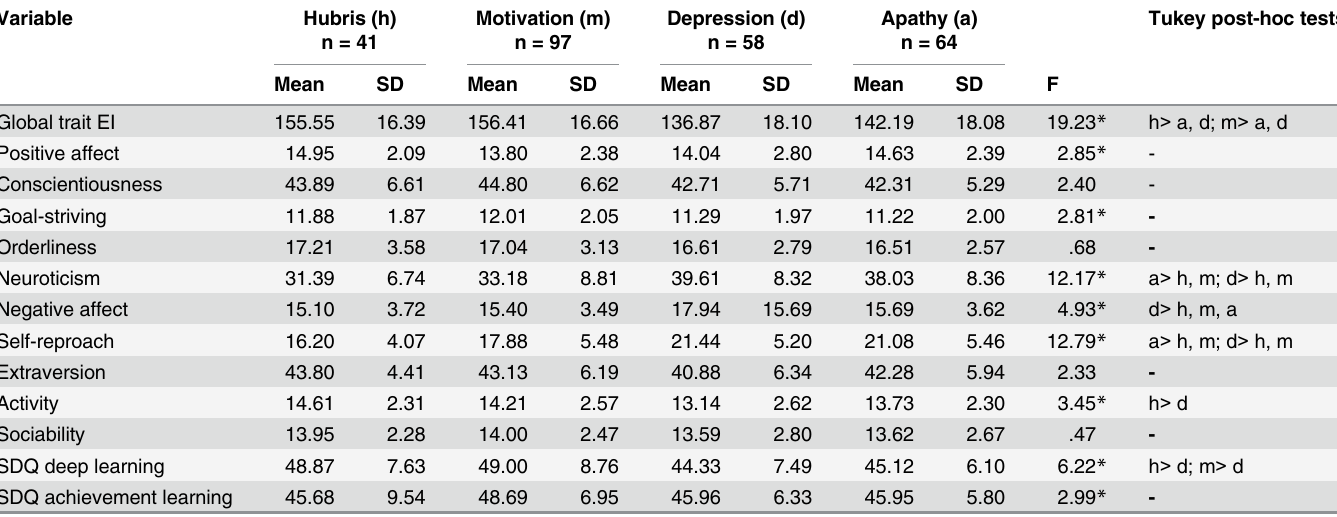
Table 3. Descriptive Statistics and One-Way ANOVA Results for the Finance Classification.